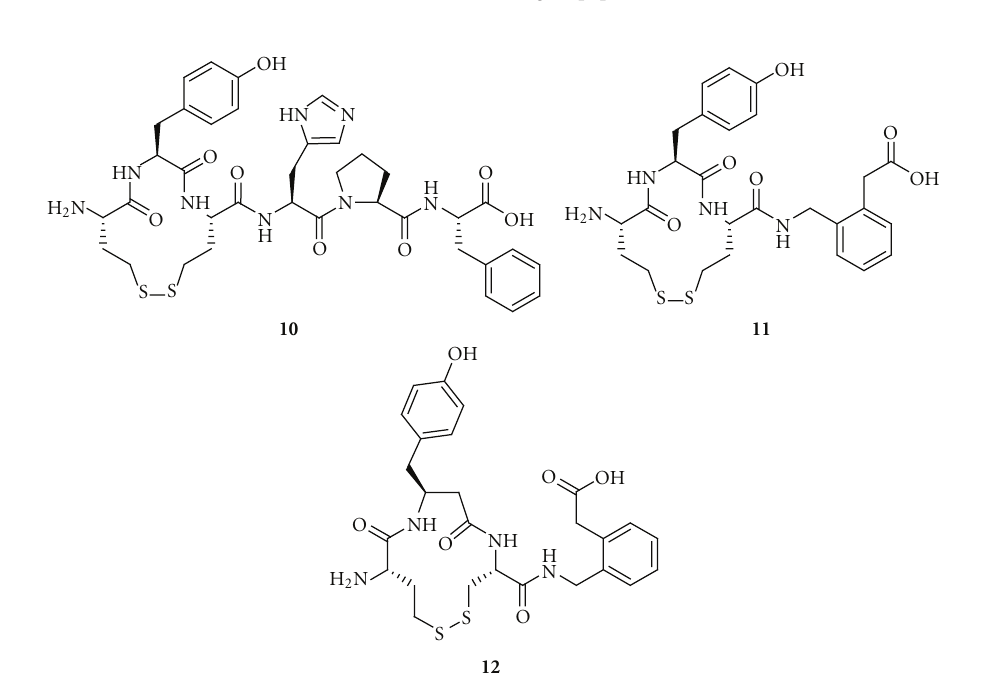
Figure 11: The structures of three IRAP inhibitors from a series of disulfide-cyclized Ang IV peptidomimetics. The ability to inhibit IRAP increases from 10 to 12 . Both 11 and 12 have 2000-fold selectivity for IRAP over AP-N.